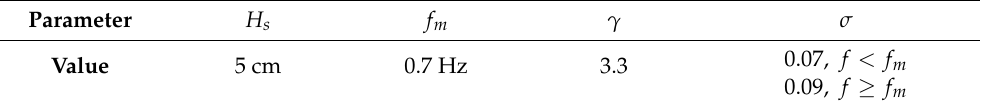
Table 1. The parameters of JONSWAP wave spectrum.